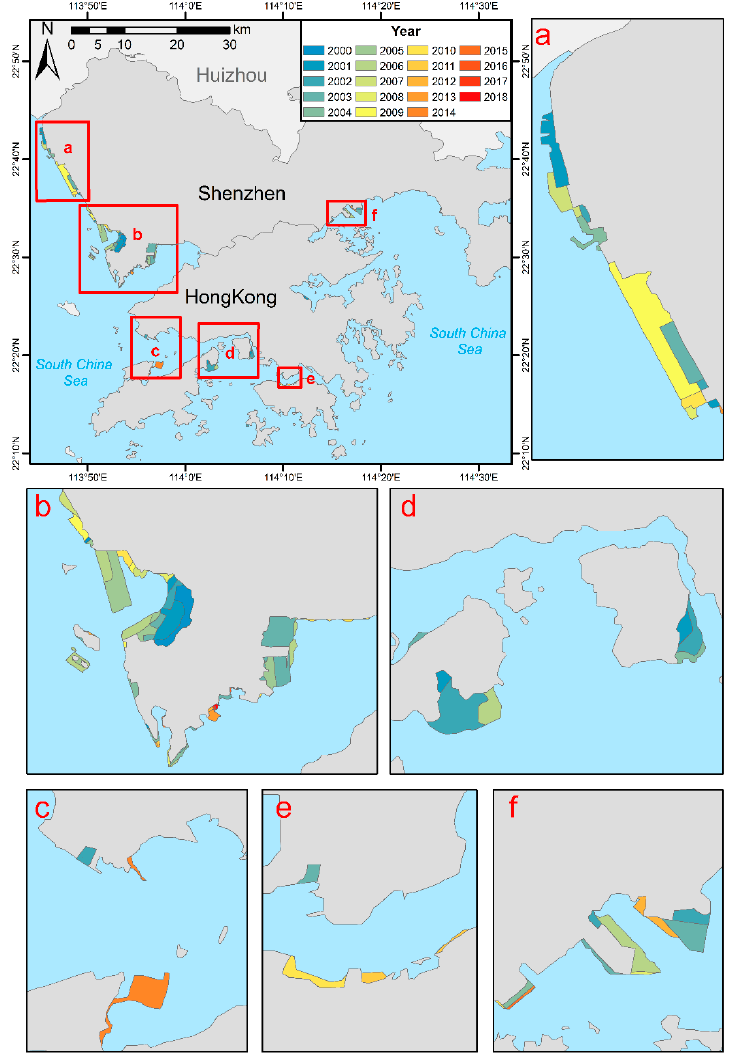
Figure 5. Spatial distribution of the coastal reclamation in Shenzhen and Hong Kong over 2000–2018. Different colors indicate coastal reclamation in different years. Six typical areas of coastal reclamation were enlarged to demonstrate the detailed information of coastal reclamation. ( a ) The western coast of Baoan District in Shenzhen; ( b ) the southern coast of Shenzhen Baoan District and the Shekou Peninsula in Nanshan District; ( c ) the Chek Lap Kok; ( d ) the northeast coast of Lantau Island and Tsing Yi Island; ( e ) Hong Kong Victoria Harbour; and ( f ) Shenzhen Yantian District East Coast.